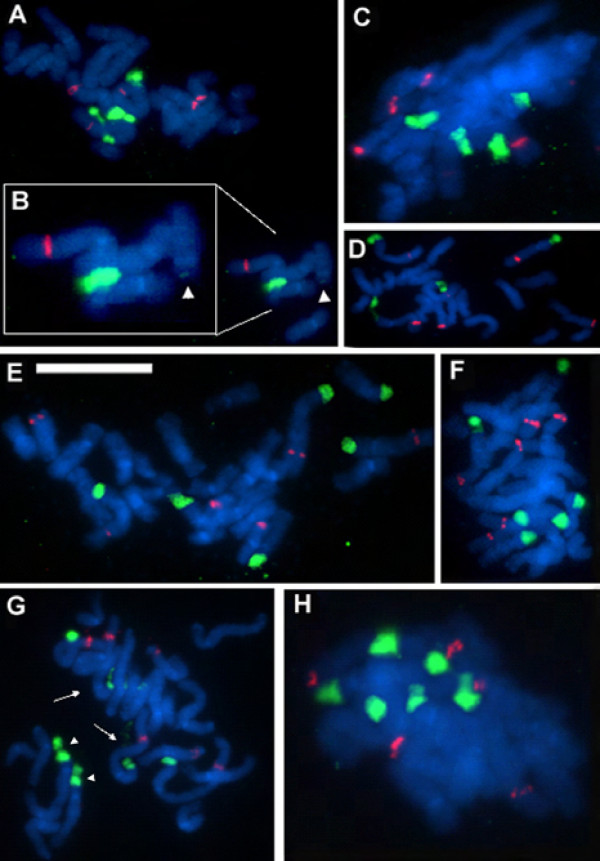
FISH to metaphase spreads of synthetic T. mirus. The probe labels and scale bar are as in Figure 4. Individuals 73-14 (A, B), 70-4 (C), and 73-13 (D) had four strong plus 0-2 very weak signals (dependent on particular metaphase and sample). (B) is an expanded region of (A) showing the large locus of T. dubius origin and the minute Dpo locus (arrowheads) left after the deletion of the majority of genes from the array. Lineages 98-1 (E), 134-15 (F), 116-1 (G), and 135-5 (H) showed regularly six 18S rDNA signals. The metaphase in (G) has largely decondensed Adu (arrows), partially decondensed Dpo (arrowheads), and fully condensed Apo loci.